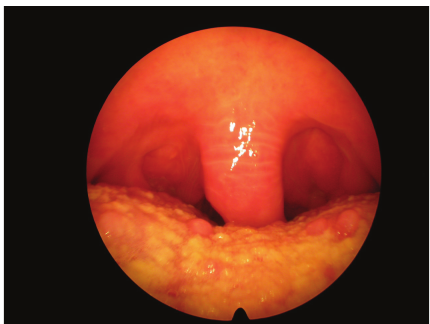
Table 1: EK sign according to AHI.